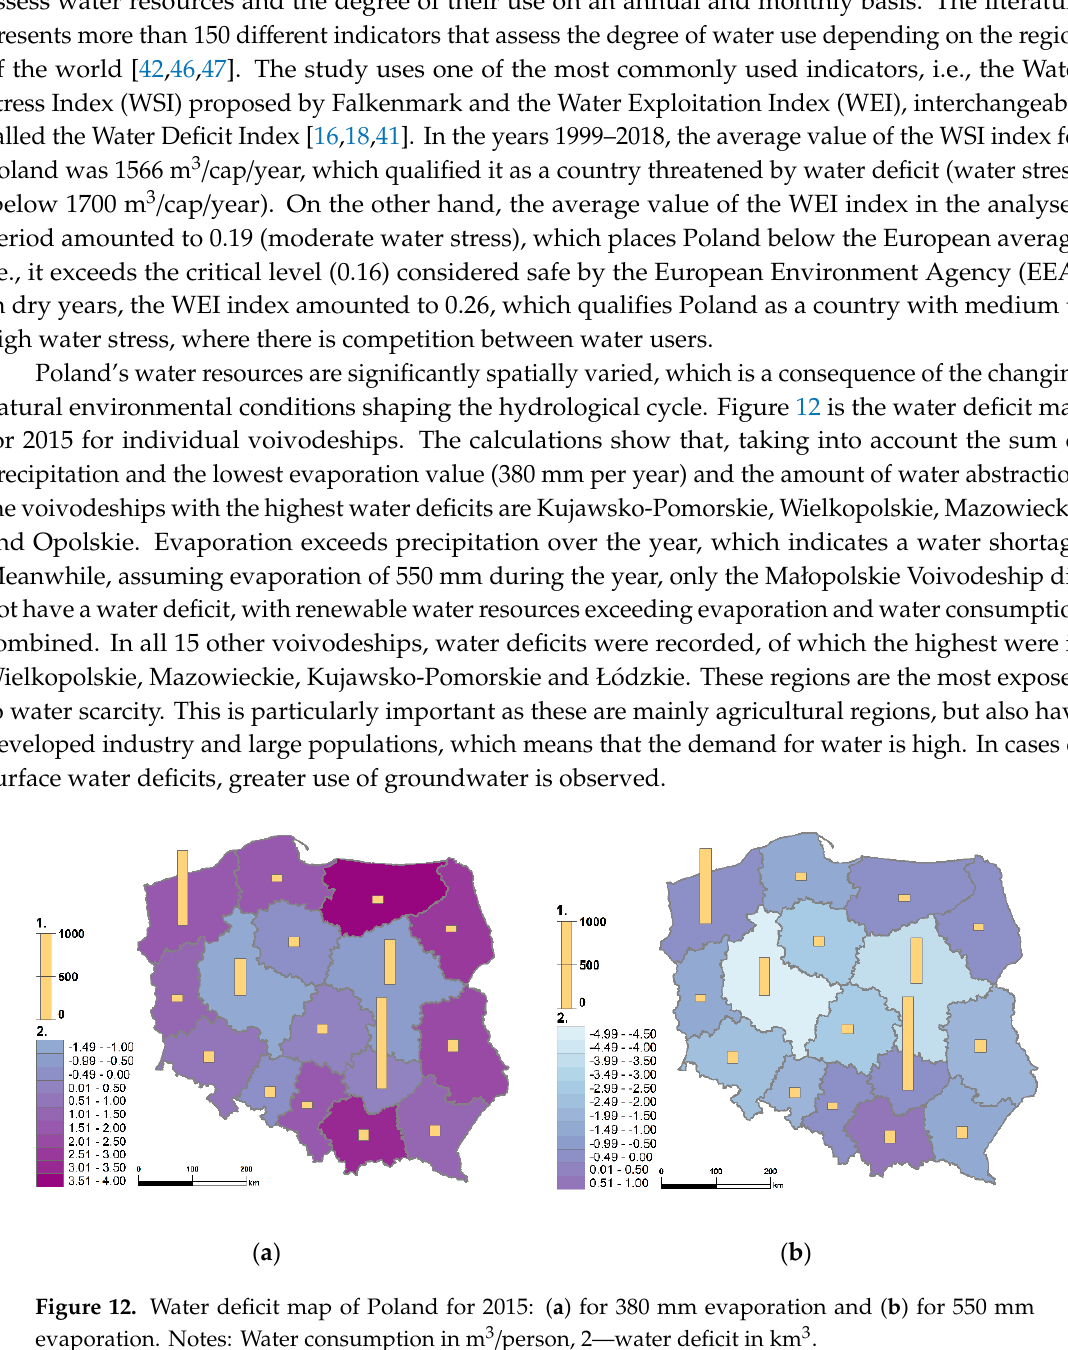
17 of 23 Figure 11. Structure of water consumption in Poland (by voivodeship) in 2010 ( a ), 2015 ( b ) and 2018 ( c ) (based on [26]). Explanations: 1—water consumption in m 3 /capita; 2—share of % of water consumption for purposes: a—industry, b—operation of the water supply system, c—agriculture; 3— total water consumption in hm 3 ; 4—names of voivodeships according to the numbering (1—